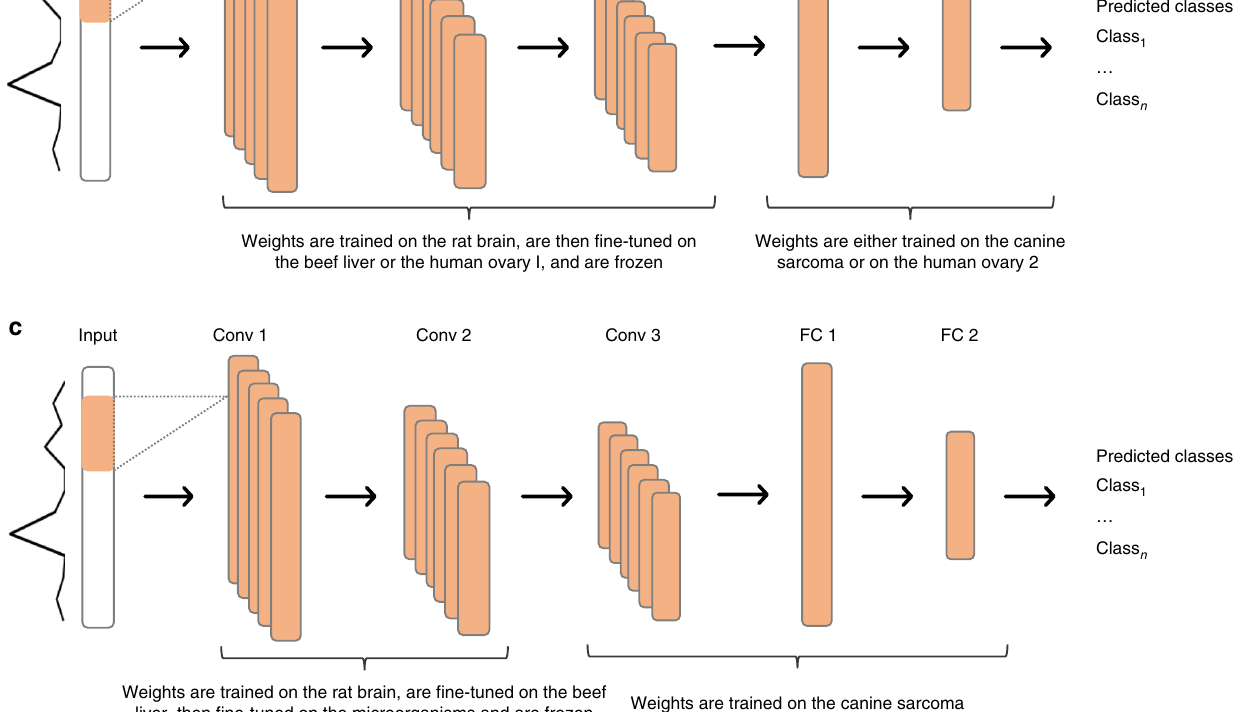
Fig. 2 Protocols of classi fi cation with variant_LeNet architecture. a Protocol of transfer learning. b Protocol of cumulative learning Scenario A. c Protocol of cumulative learning Scenario